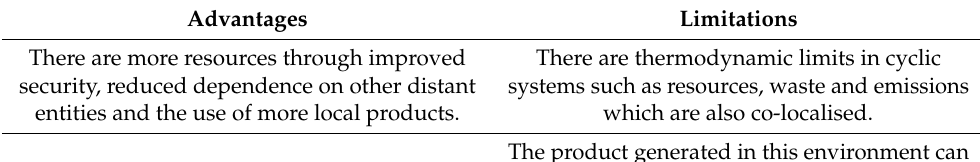
Table 1. Advantages and limitations of